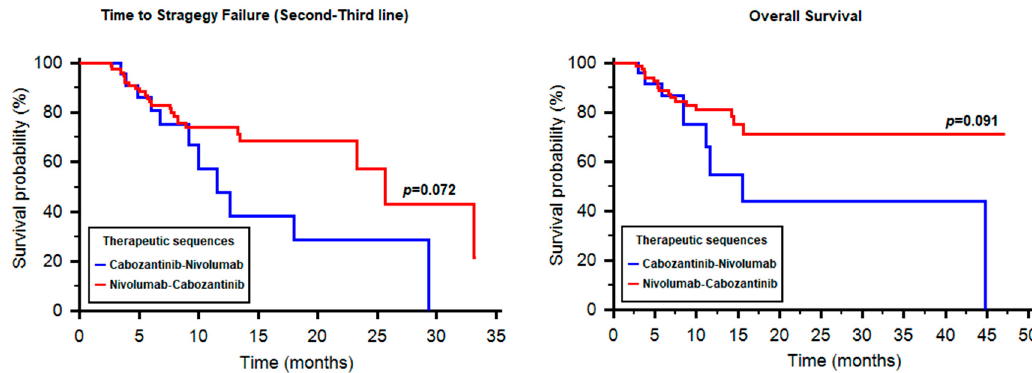
Figure 5. Time to strategy failure and overall survival in patients treated with the